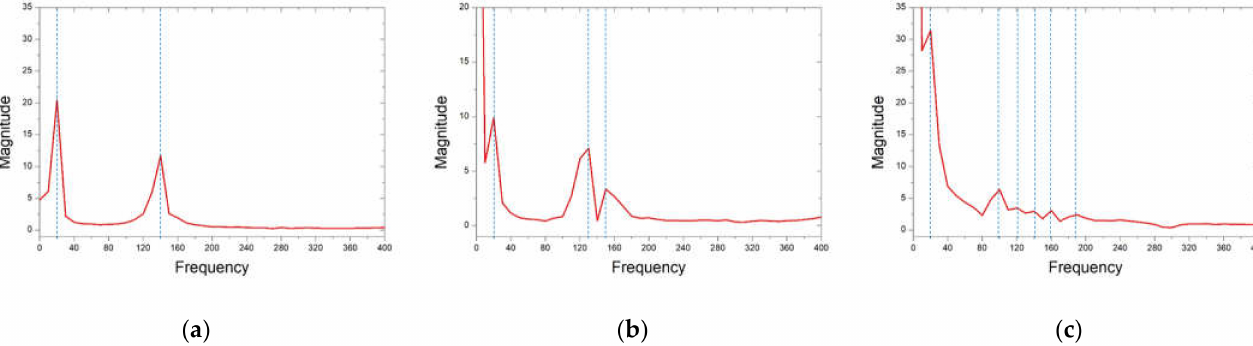
Figure 7. Vibration frequency spectrum under the variation of inlet velocity (V ∞ ): ( a ) 0.10 m/s; ( b ) 0.24 m/s; ( c ) 0.50